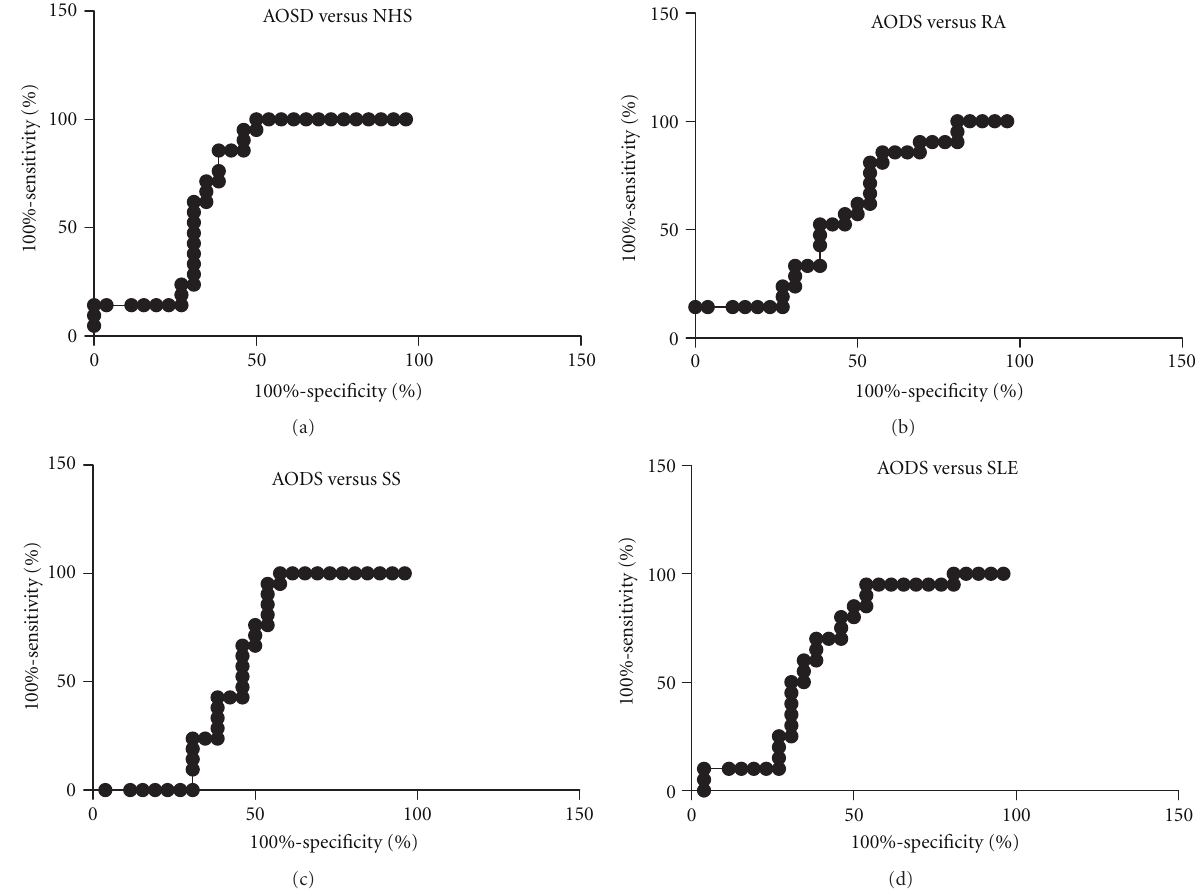
Figure 3: Area under the receiver operating characteristic curves for detection of AOSD by reference to the level of serum IL-18. (a) AOSD versus NHS; (b) AOSD versus RA; (c) AOSD versus SS; (d)AOSD versus SLE.